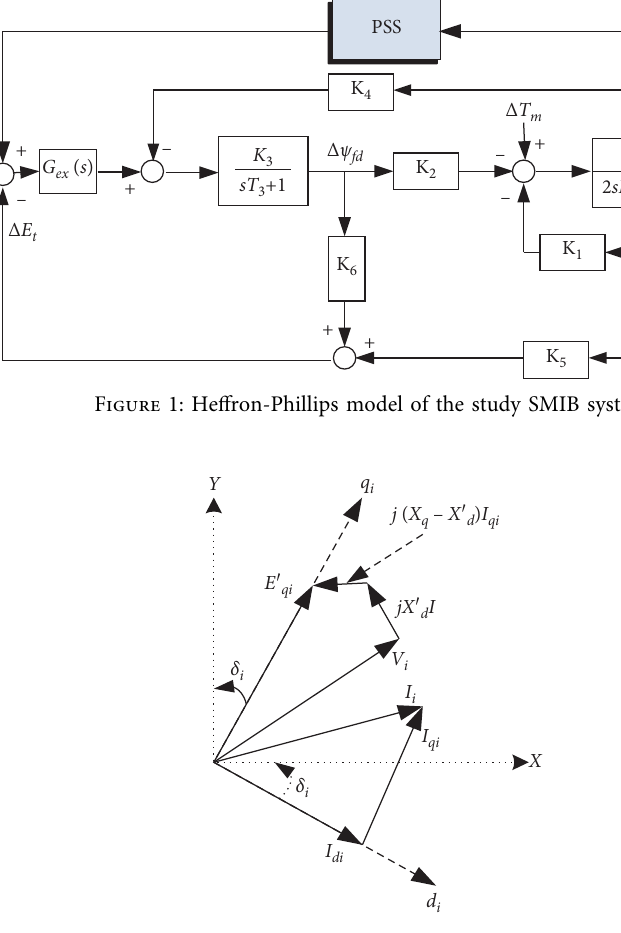
Figure 2: Phasor diagram of a multimachine power system.